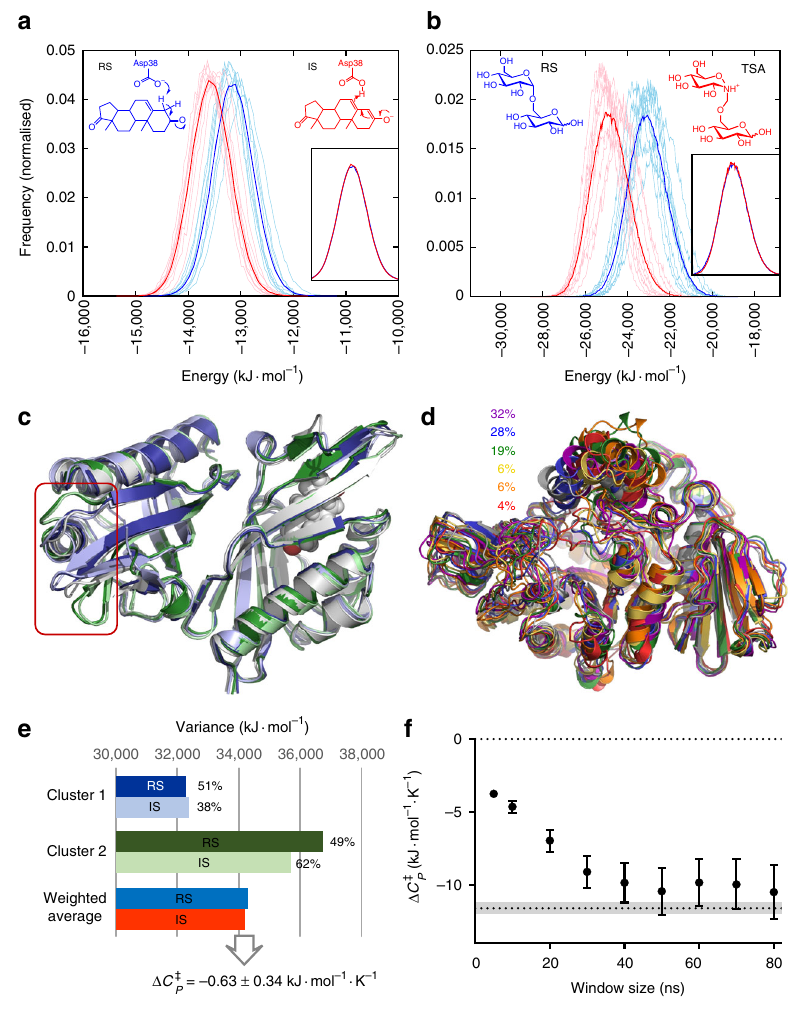
Fig. 2 Sampling and Δ C z P calculation in simulations. a-b Histograms of energies from 50 to 500 ns MD simulations for KSI ( a ) and MalL ( b ). Thin lines are individual runs, thick lines are the average of ten runs. Insets show overlay of histograms for both states, and the structures indicate the species simulated (RS reactant state, IS intermediate state, TSA transition state analogue). c Representative structures for the two distinct conformational clusters present in the KSI simulations of both states (reactant state in blue and green, intermediate state in pale blue and green, starting structure in light grey). Box highlights the region with structural differences. d Representative structures for the six main conformational clusters in MalL reactant state simulations and their occupancies (starting structure in light grey). e Variance in energies for the two clusters identi fi ed in the KSI simulations, with cluster occupancies (in %) and weighted average variance for both states. f Convergence with moving average-window size of Δ C z P values calculated for MalL, with value determined from experiment indicated by dotted line (with grey area indicating standard deviation). Error bars indicate the standard deviation of the calculated Δ C z P values based on the cumulative standard deviation for each state, from 10 independent